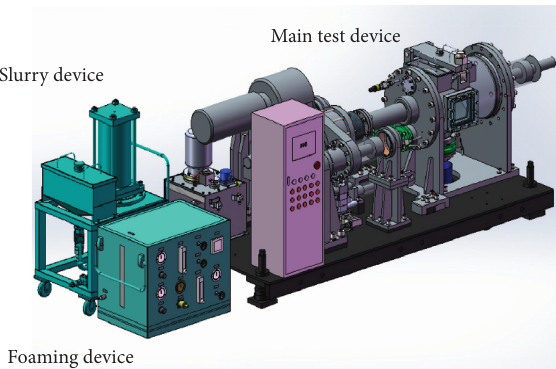
Figure 1: Ground suitability test system for EPB tunneling.